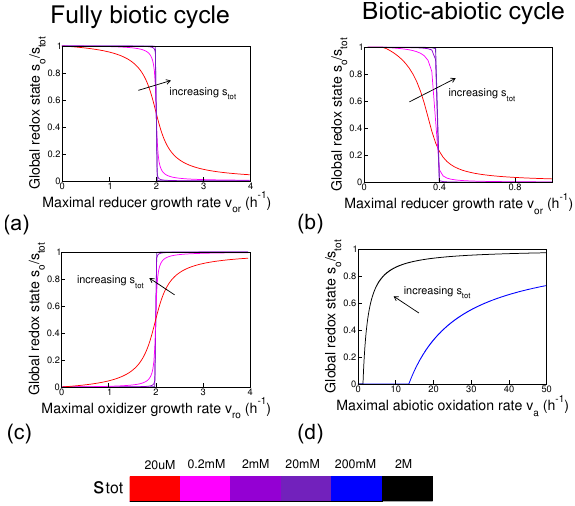
Figure 2. Redox regime shifts in model nutrient cycles. The global redox state, as measured by the oxidized fraction s o /s tot , predicted by the steady-state solution of the model equations for the fully bi- otic cycle ( a and c , Eqs. 1–3) or the biotic–abiotic cycle ( b and d , Eqs. 1, 2, and 6) is plotted as a function of parameters that form proxies for the degree of reductive or oxidative driving. v or is taken as a proxy for electron donor (acetate) availability, and v ro is taken as a proxy for electron acceptor (oxygen) availability. These pa- rameters are, for reductive driving, the maximal growth rate of the reductive population, v or ( a and b , keeping v or fixed at 2h − 1 or v a = 0 . 2µMh − 1 ), and, for oxidative driving, either the maximal growth rate of the oxidative population v ro ( c , keeping v ro fixed at 2h − 1 ) or the maximal abiotic oxidation rate v a ( d , also with v ro = 2h − 1 ). The results show a shift between oxidized and reduced ecosystem states as a threshold in reductive or oxidative driving is crossed; the sharpness of this transition increases with the concen- tration of the chemical species being cycled, s tot (shown in the color bar). The other parameters are K or = K ro = K a = 1µM (Ingvorsen et al., 1984), n or,max = n or,max = 9 × 10 7 cellsL − 1 , d = 0 . 1h − 1 , and γ = 3 × 10 − 8 µmolescell − 1 (Jin et al., 2013). The analytic forms for the steady-state solutions are given in Sect.